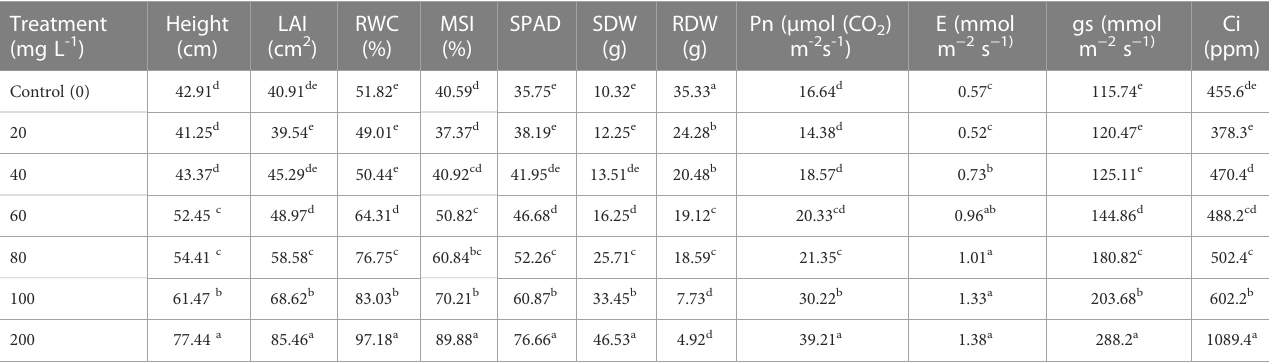
TABLE 1 Effects of ZnO NPs application on morpho-physiological traits of B. juncea .